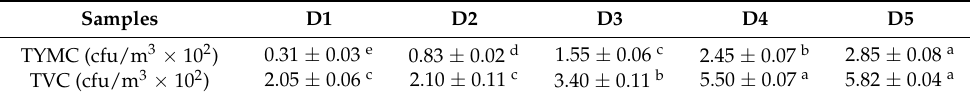
Table 2. Microbiological parameters in the storage space during cheese